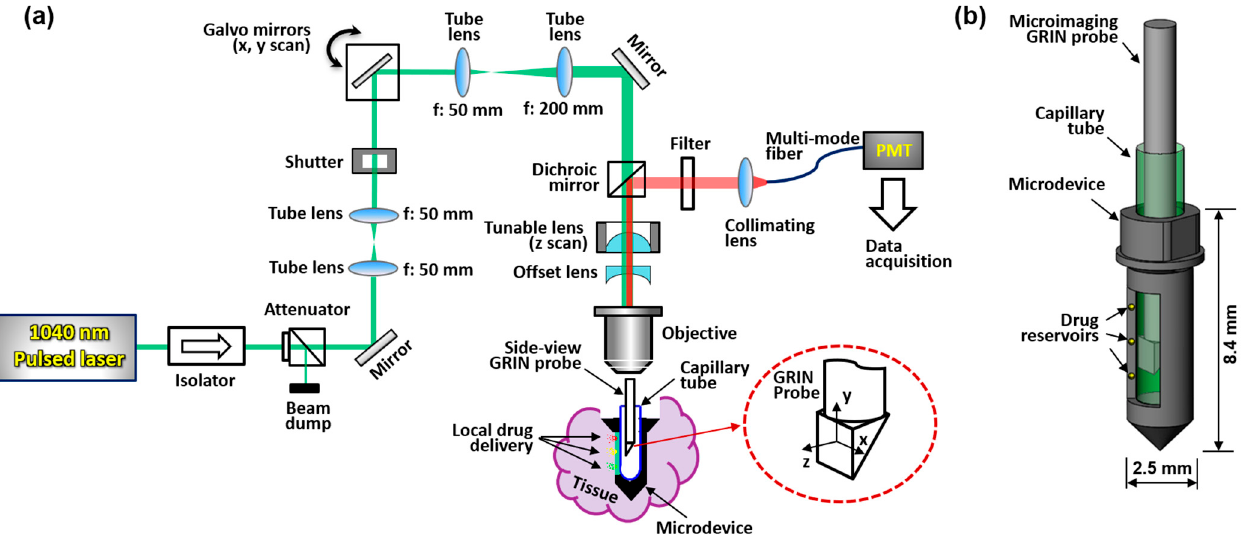
Figure 1. Two-photon MI-MD system for local drug delivery testing. ( a ) Schematic of the whole system, ( b ) close-up view of the MI-MD assembly. PMT, photomultiplier tube.